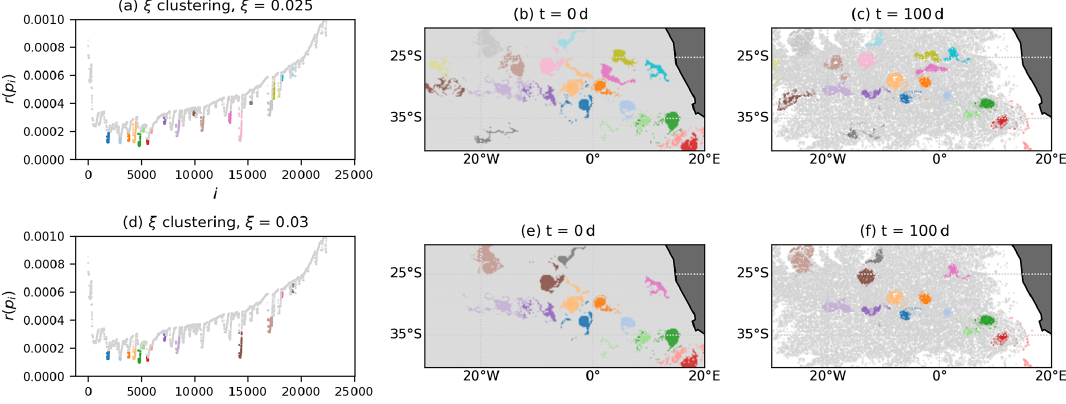
Figure C3. Result of OPTICS applied to the K = 40 spectral embedding of the network defined in Eq. (C1), with d = 200km and s min = 100. Grey particles are classified as